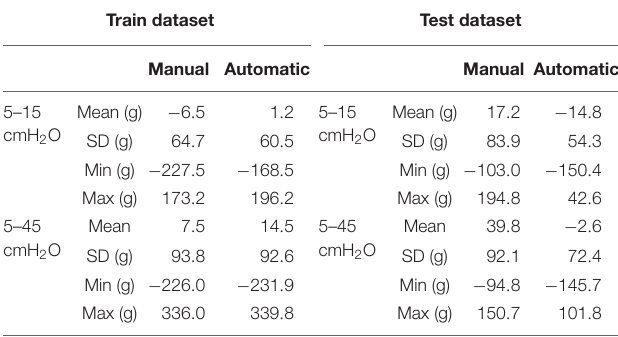
TABLE 4 | Differences in lung weight detected at different airway